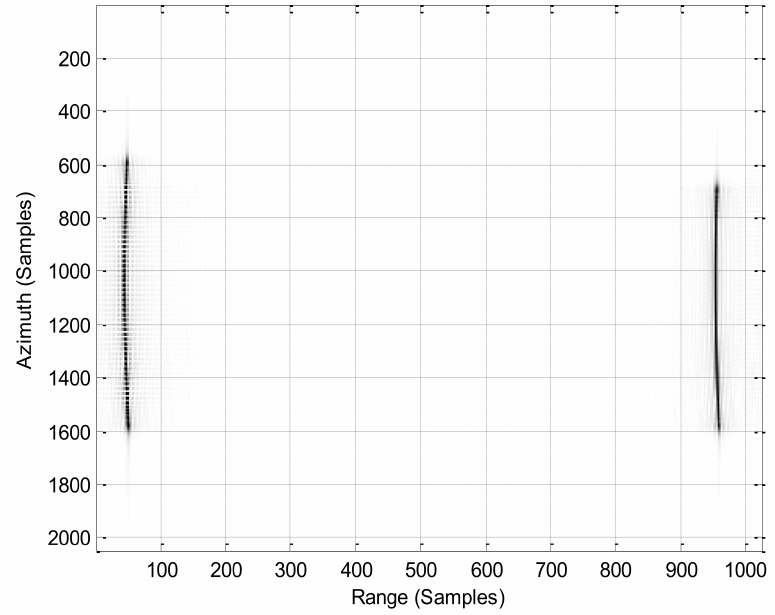
Figure 11. Range-compressed data in the range-Doppler domain by MATLAB